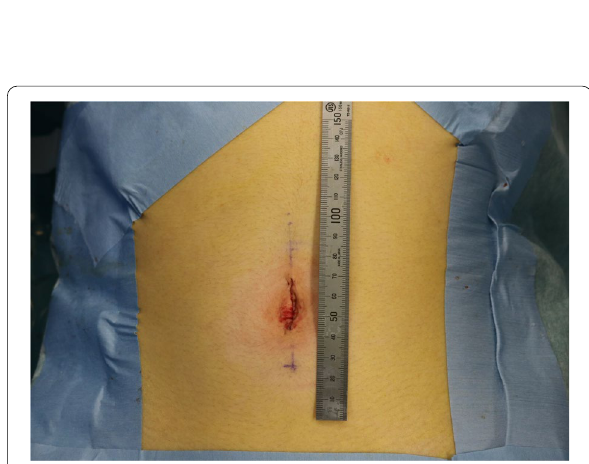
Fig. 2 Postoperative scar after single-incision laparoscopic surgery. The diameter of the incision was 2.5 cm